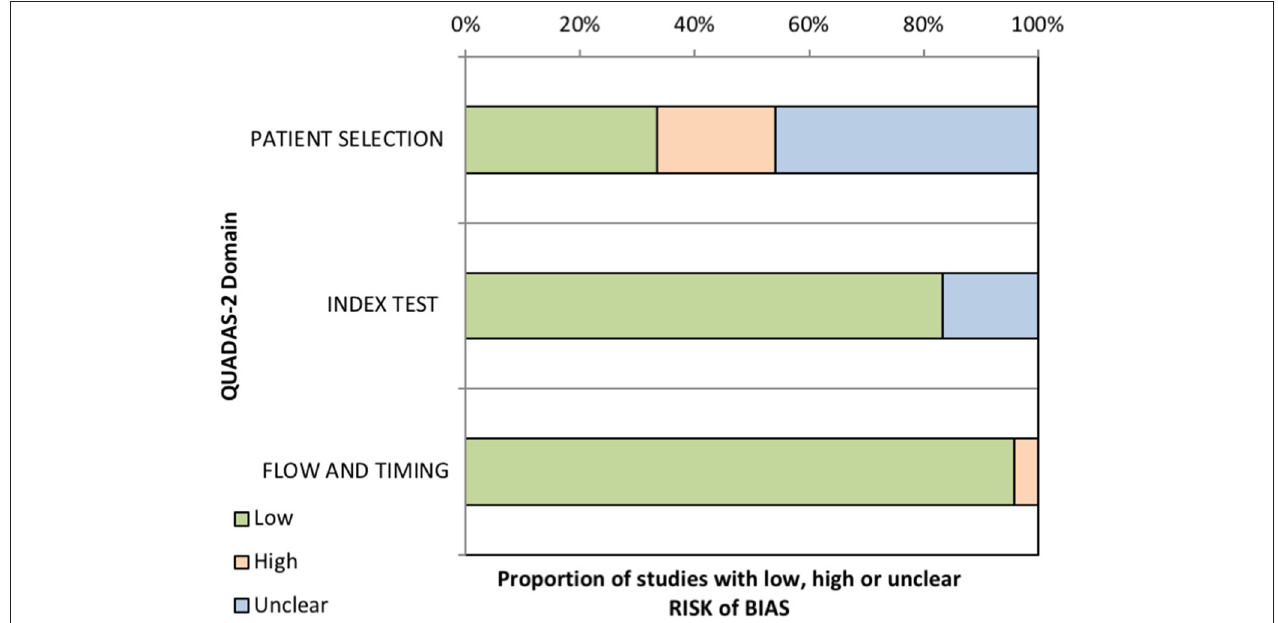
FIGURE 4 | Results of the methodologic assessment using the QUADAS-2 tool showing the proportion of studies with low, high, or unclear risk of bias.